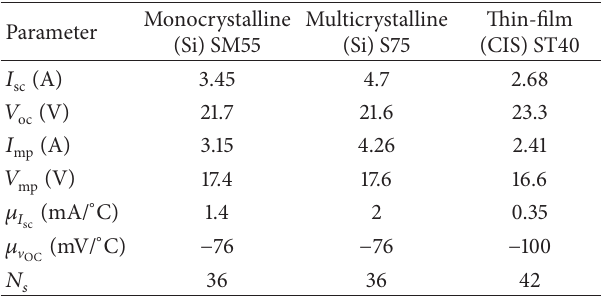
Table 1: Specifications for the three modules used in the experi- ments.